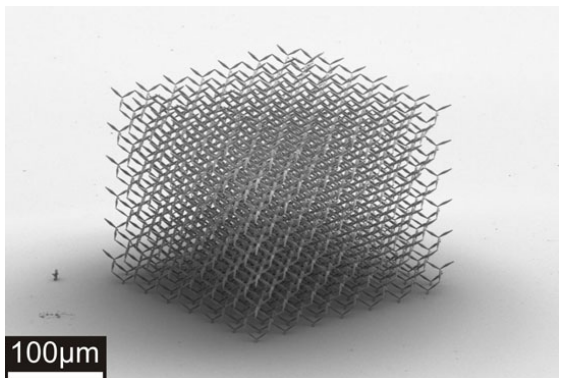
Figure 9. A pentamode material as realized by Kadic [69] with 3D laser lithography. The unit elements are linked to each other with connections that are 0.55 µ m